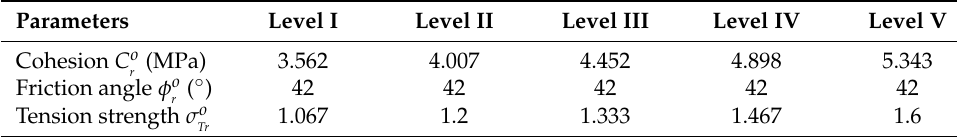
Table 2. Mechanical properties of graded rock.